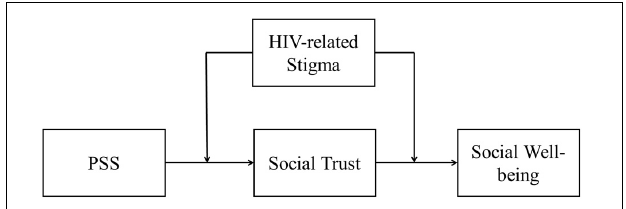
FIGURE 1 | Conceptual